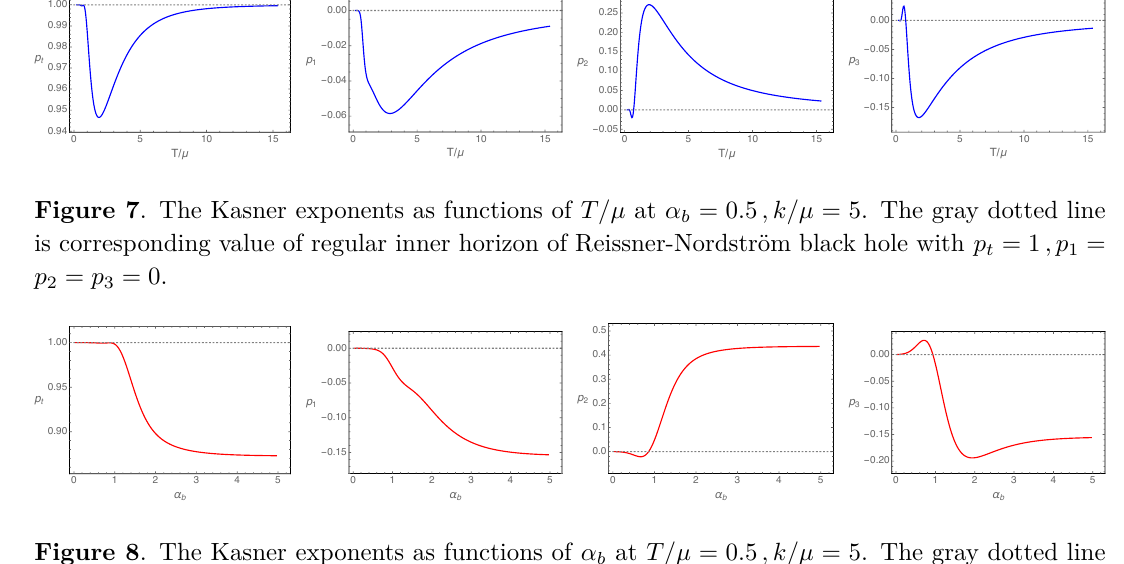
Figure 8 . The Kasner exponents as functions of α b at T/µ = 0 . 5 , k/µ = 5 . The gray dotted line is corresponding value of regular inner horizon of Reissner-Nordström black